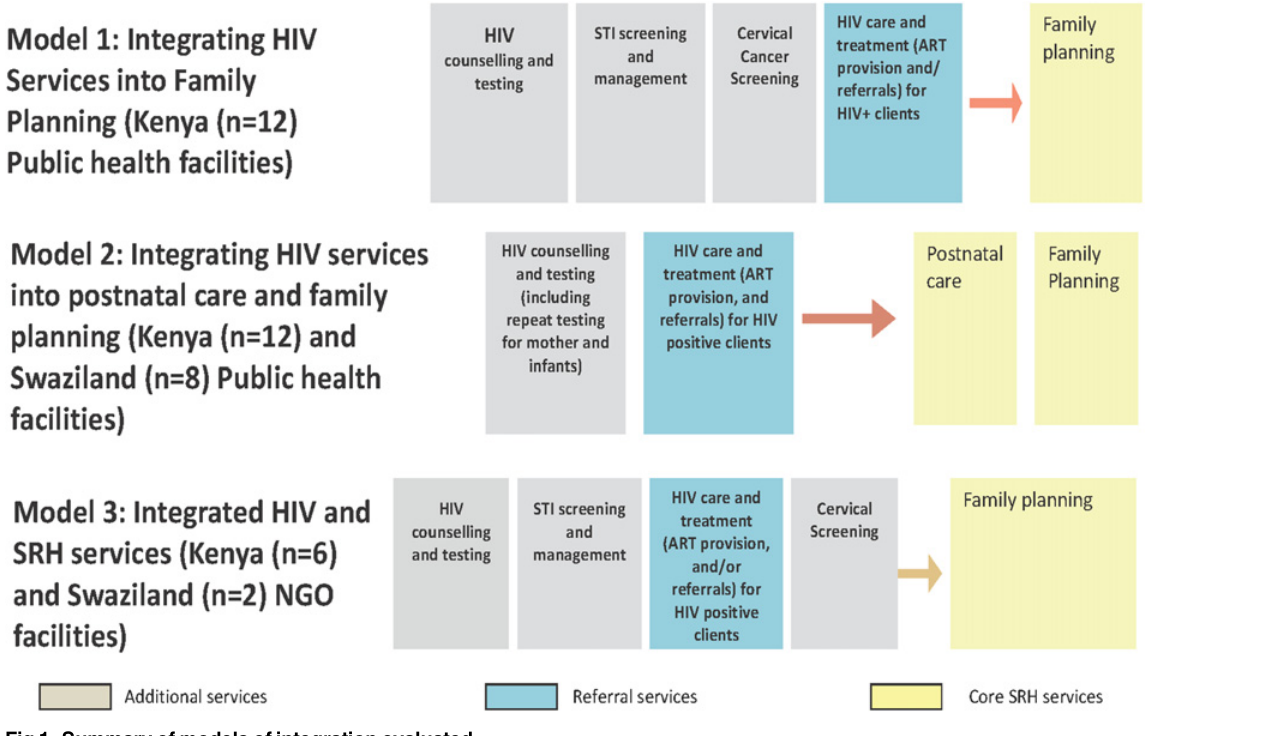
Fig 1. Summary of models of integration